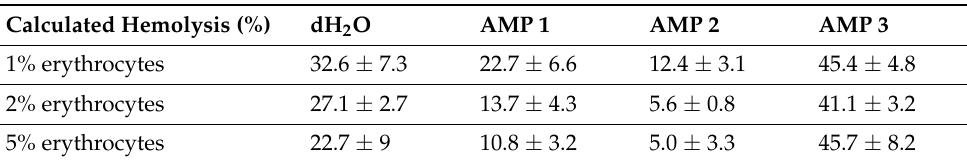
Figure 3. OD measurements at 405 nm (Y-axis) of free hemoglobin in 1%, 2%, and 5% erythrocyte (EC) solution of pooled blood originating from 10 different human individuals, incubated for 60 min at 37 ◦ C with PBS (negative control), 10% Triton X-100 (positive control), dH 2 O, or AMPs 1, 2, or 3 (100 µ M). Average values from three experimental replicates, each containing two technical replicates, are presented with error bars (SD) and included in plots. Table 3. Calculated hemolysis ratios according to Equation (1) for AMPs 1, 2, and 3 (100 µ M) on 1%, 2%, and 5% pooled human erythrocyte solutions. Normalization was performed on data averaged from three experimental replicates, each containing two technical replicates, using 10% Triton X-100 and PBS samples as positive and negative controls,